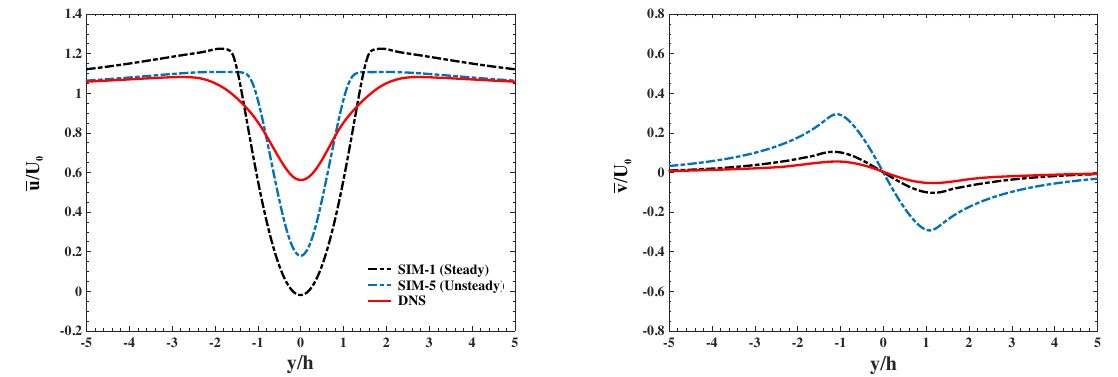
Figure 8. Comparison of mean velocities at x = 5 h , calculated by steady and unsteady k − ε and compared to Reference